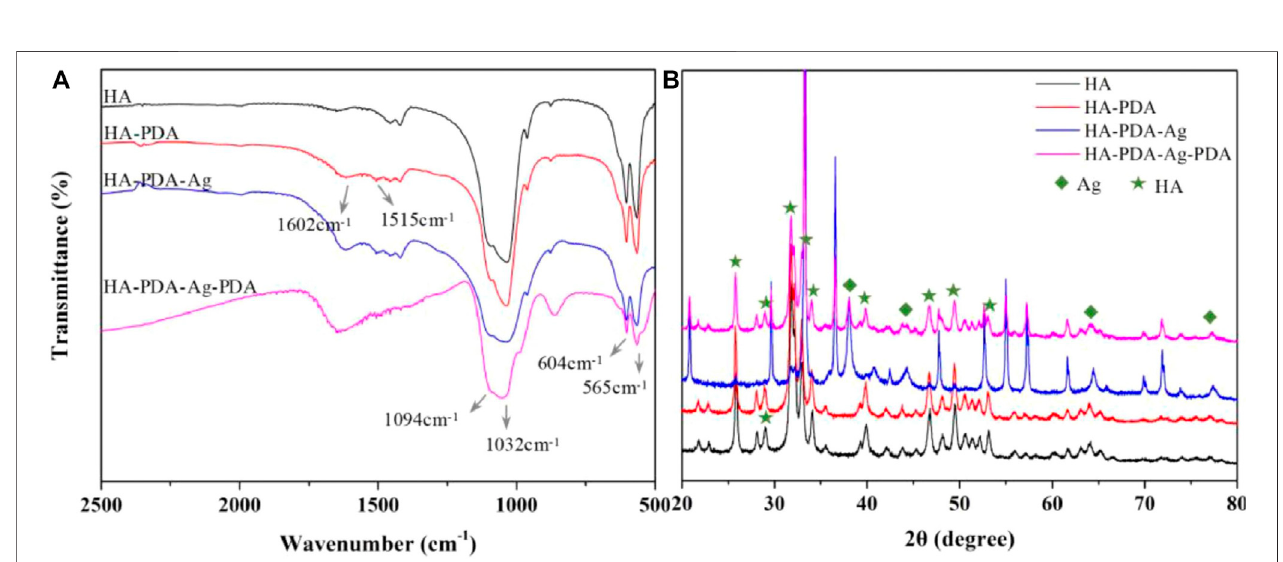
FIGURE5| AfterPDAmodi fi cation and Agdecoration,changesofchemical componentsonHAsubstrates are detected by (A) FTIR, andthe characteristic peaks are identi fi ed. The characteristic peaks ofPDA (1602 cm - 1 and 1515cm - 1 ) canbe observed. Changes ofcrystalline structures are detected by (B) XRDanalysis, and the crystalline structures stay unchanged after PDA modi fi cation, where the quadrangles represent peaks of Ag and the pentagrams represent peaks of HA. (Zhang et al., 2021). Copyright 2021, Elsevier.